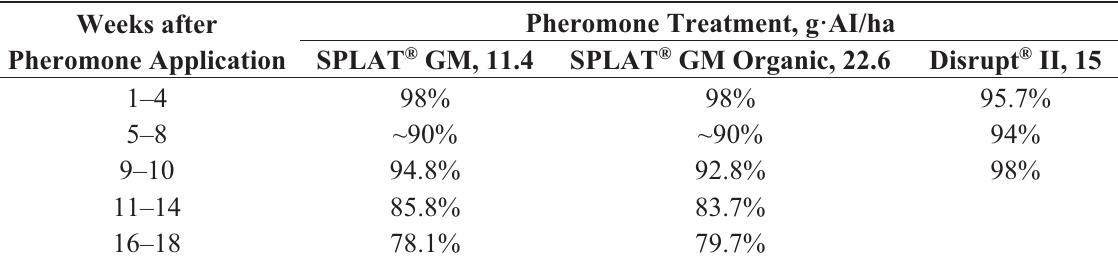
Figure 2. Male moth catches in pheromone-baited traps in ( a ) Virginia and ( b ) Wisconsin, 2010. Table 1. Decline in trap catch reduction (% of control) in experimental plots treated with various formulations and dosages of